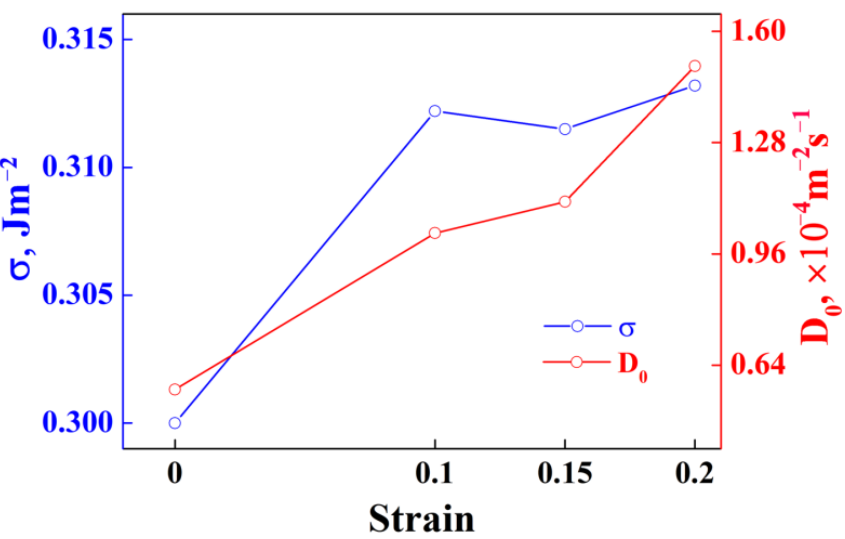
D for the alloy samples with different strains. Figure 7. Values of σ and D 0 for the alloy samples with different 0